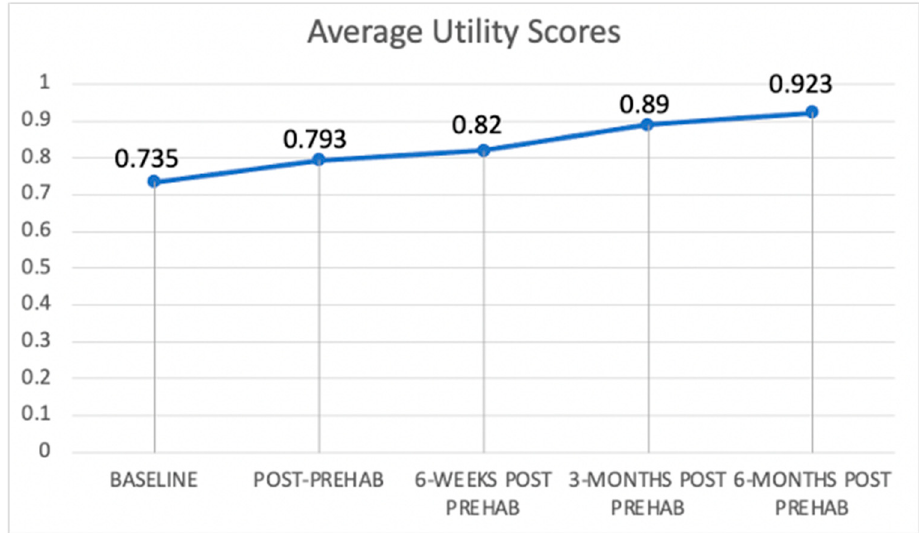
Figure 2. Trajectory of EQ-5D utility scores.